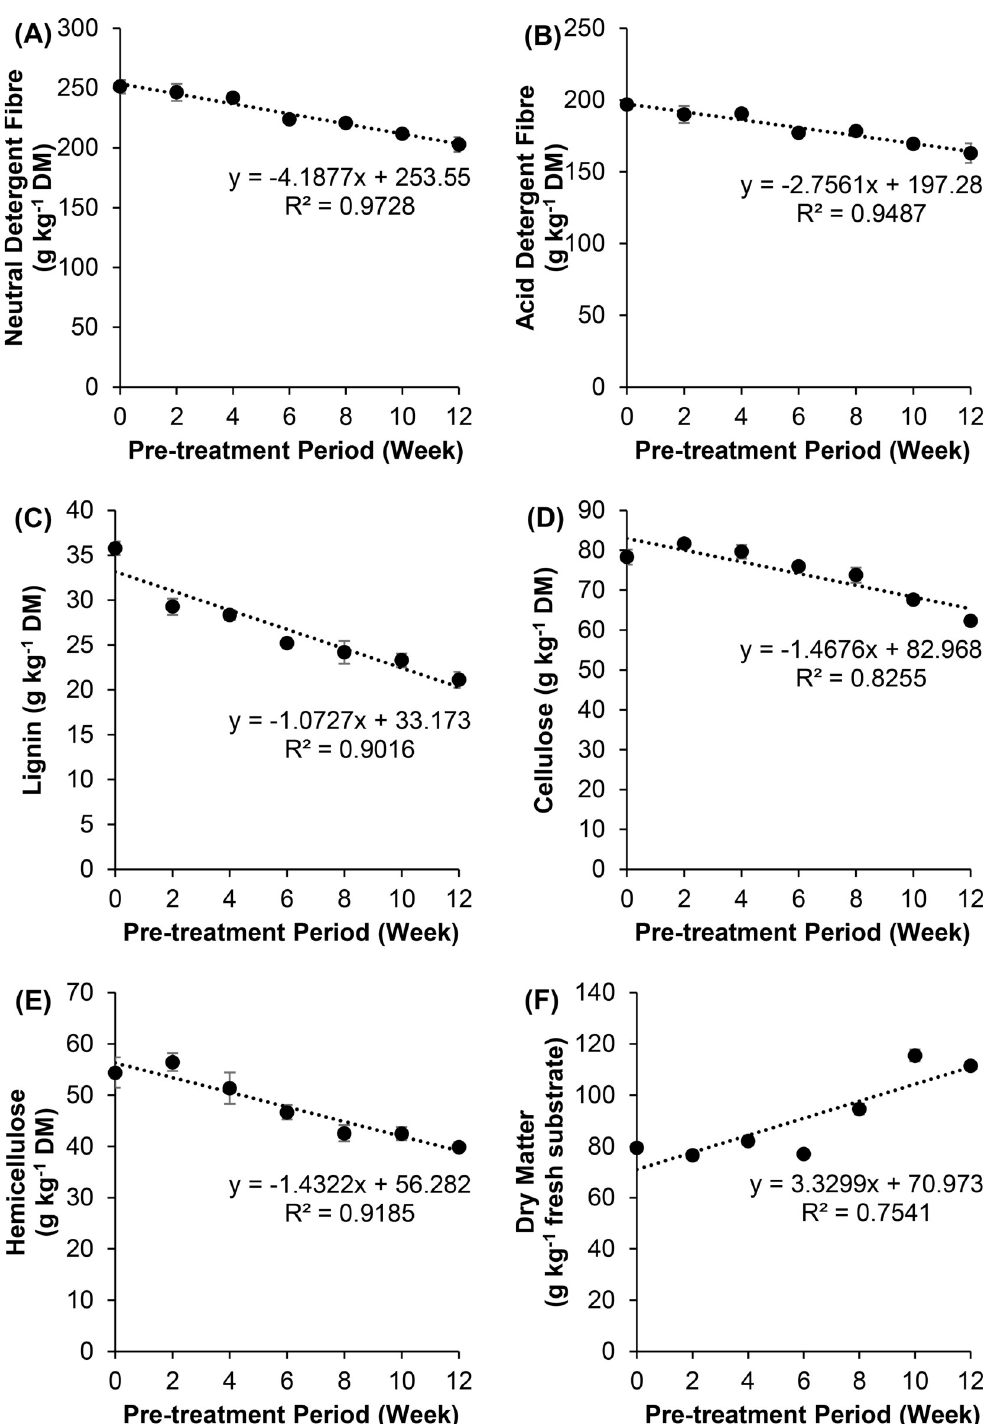
Fig 1. Changes in fibre composition and dry matter (means ± standard error) of OPEFB pre-treated with G . lucidum across treatment period were fitted to linear model. (A): Neutral detergent fibre. (B): Acid detergent fibre. (C): Lignin. (D): Cellulose. (E): Hemicellulose. (F): Dry matter.